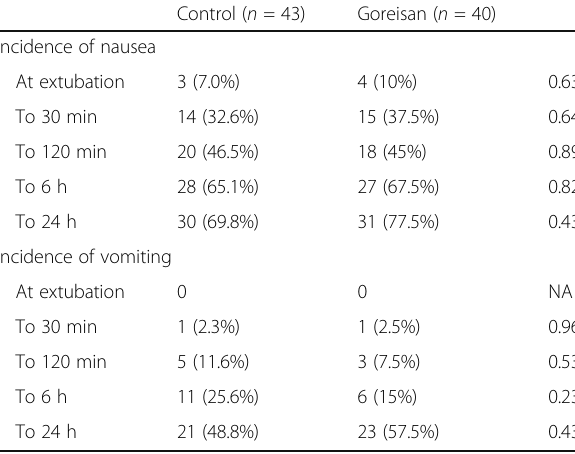
Table 5 Accumulative incidence of nausea and vomiting